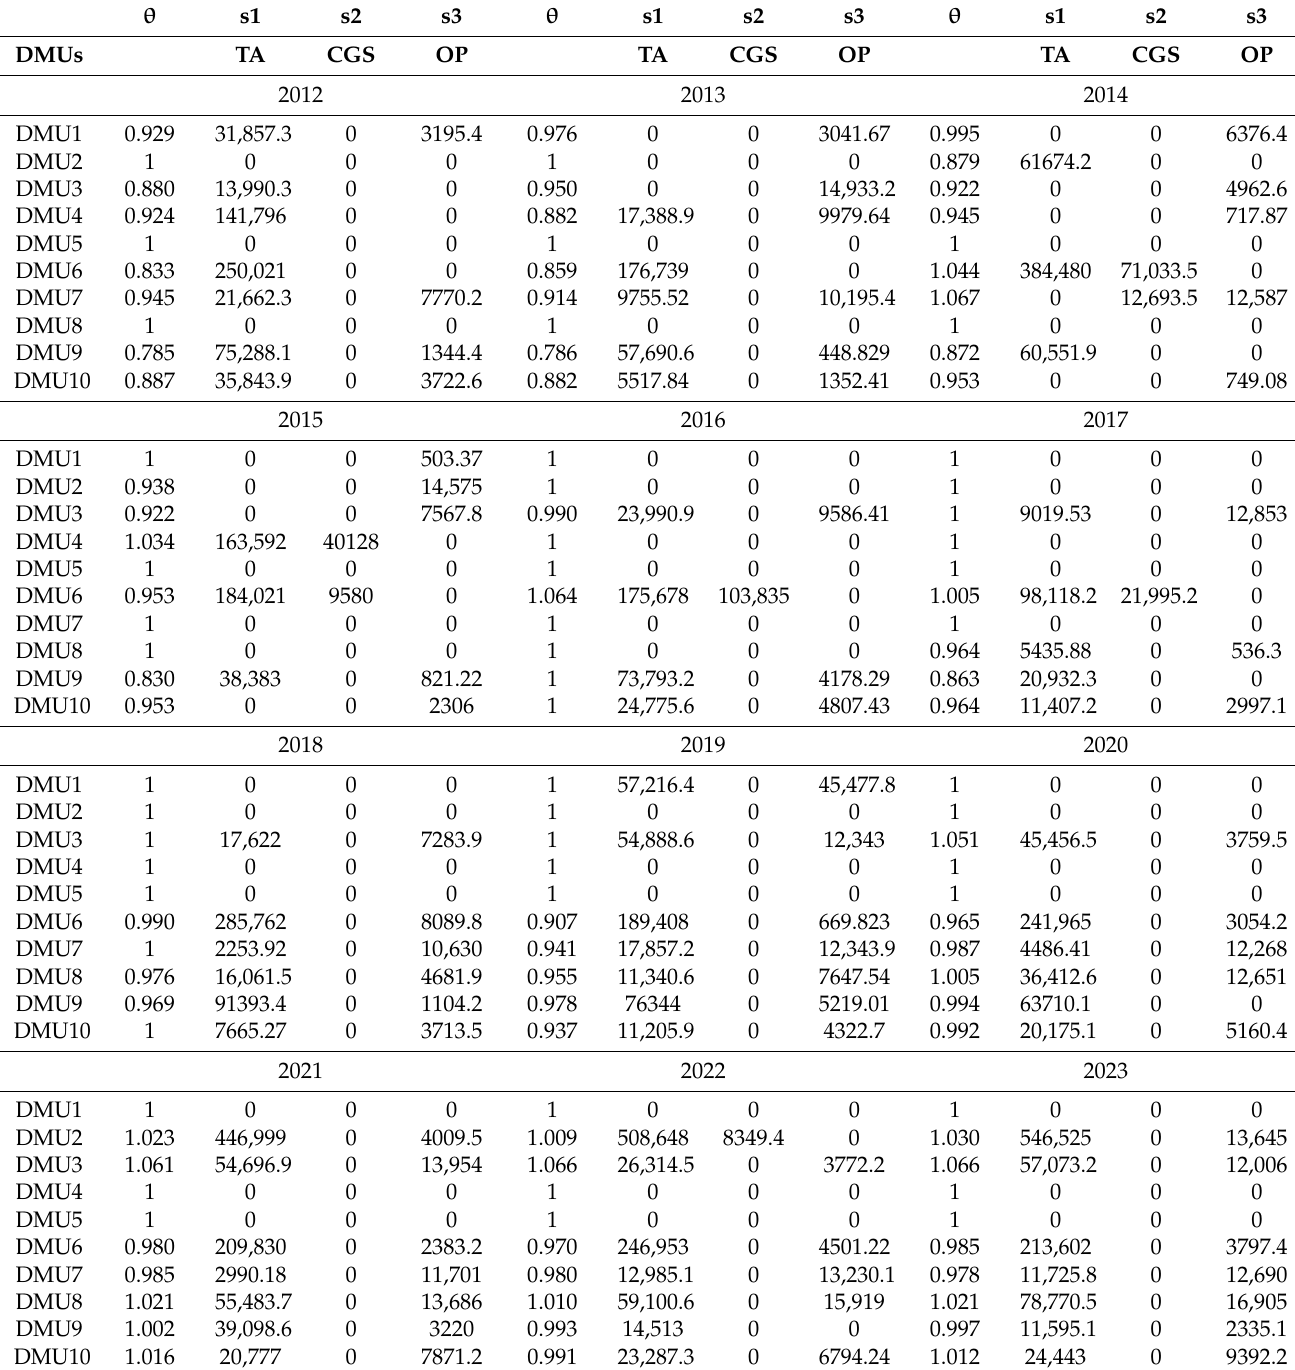
Table A6. Theta and slack(s) index of inputs for all